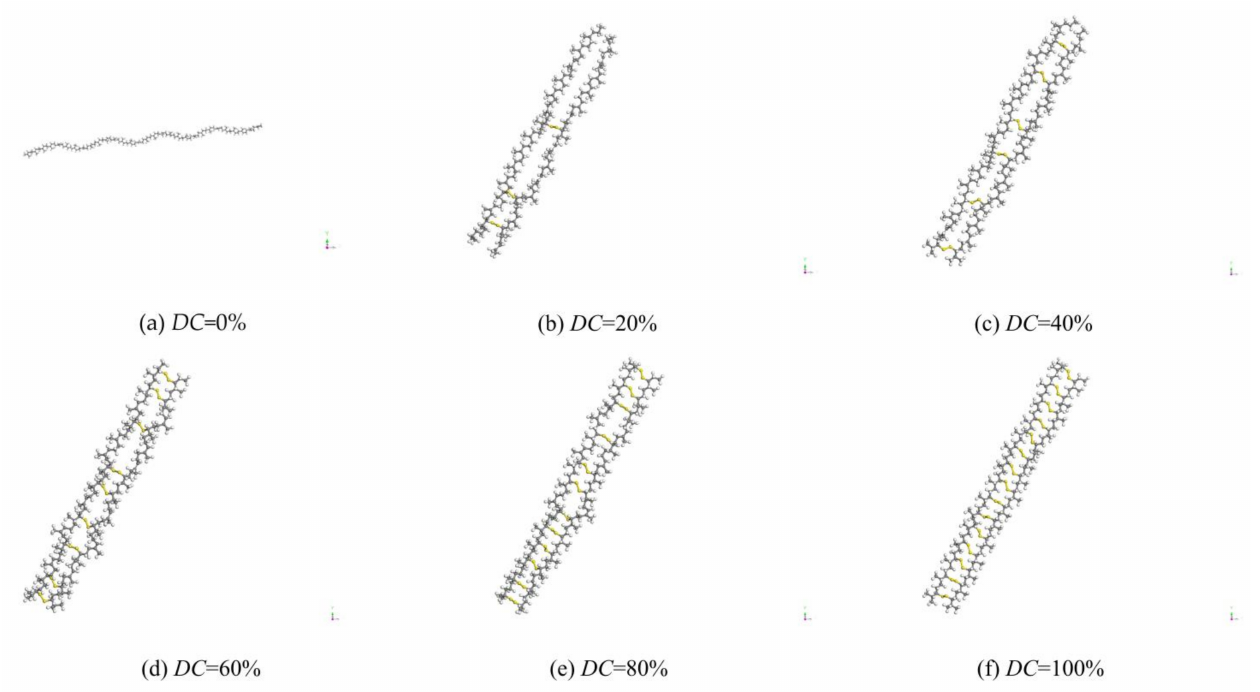
Figure 10. Vulcanized dulcimer chains with different cross-linking degrees. ( a ) SEUG molecular chain model with 0% cross-linking degree; ( b ) SEUG molecular chain model with 20% cross-linking degree; ( c ) SEUG molecular chain model with 40% cross-linking degree; ( d ) SEUG molecular chain model with 60% cross-linking degree; ( e ) SEUG molecular chain model with 80% cross-linking degree; ( f ) SEUG molecular chain model with 100% cross-linking